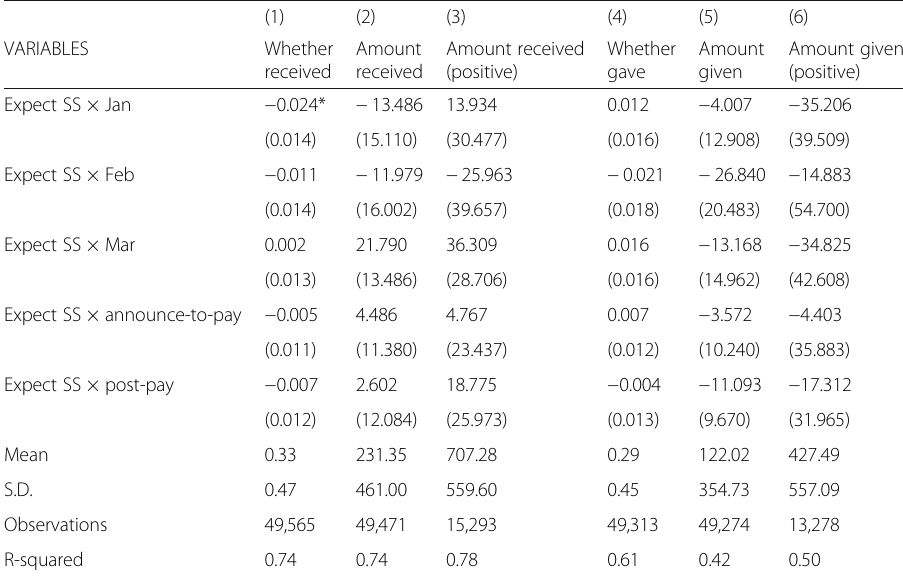
Table 7 Overall impact of expecting to receive SSS payouts on private cash transfers (1)